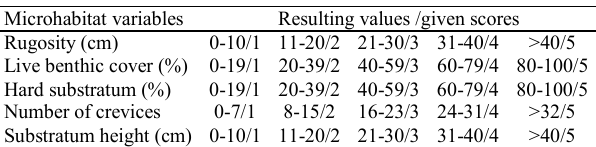
Table 1. Microhabitat variables and arbitrary scores used to elaborate an index of habitat complexity (IHC) from results of underwater visual